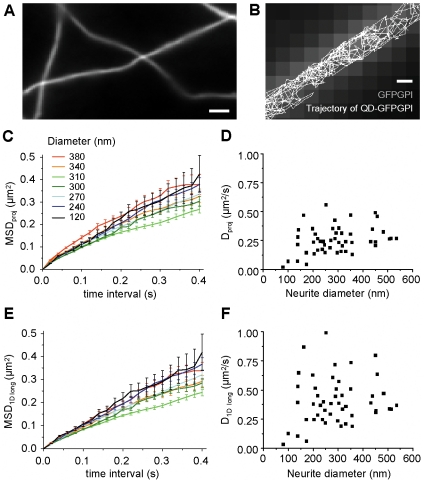
GFP-GPI diffusion on neurites.
A) Neurites (axons) of hippocampal neurons transfected with GFP-GPI. Bar: 1 µm. B) A representative trajectory of GFP-GPI labeled with a QD on a neurite (white line). Epifluorescence image of GFP is shown in the background. Bar: 200 nm. C,E,) Examples of MSD of projected trajectories (C) and of longitudinal components (E) of the displacements for trajectories on neurites of the indicated diameters (mean ± errors calculated as in ref. [18]). D,F) The diffusion coefficients Dproj (D) and D1Dlong (F) of GFP-GPI trajectories on neurites of different diameters. Pearson's correlation coefficients between the diffusion coefficients and diameter were 0.32667 (Dproj), and 0.13832 (D1Dlong) (n = 49 trajectories on different neurites).